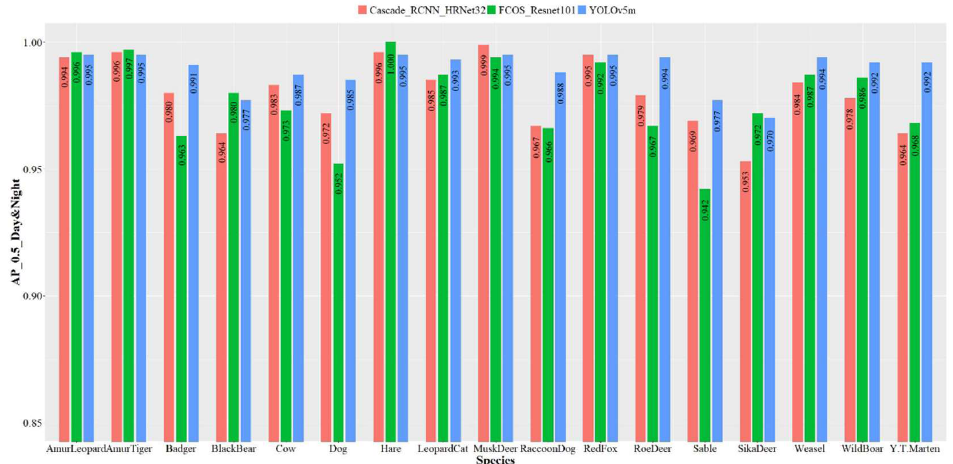
Figure 7. Recognition accuracy of each species of the three object detection models based on the day-night dataset. The y -axis is the AP value when IOU = 0.5, ranging from 0.85–1; the x -axis is the species.